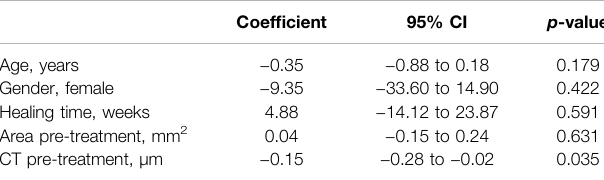
TABLE 3 | Linear regression analysis. Outcome: percentage change in CT at the end of cenegermin